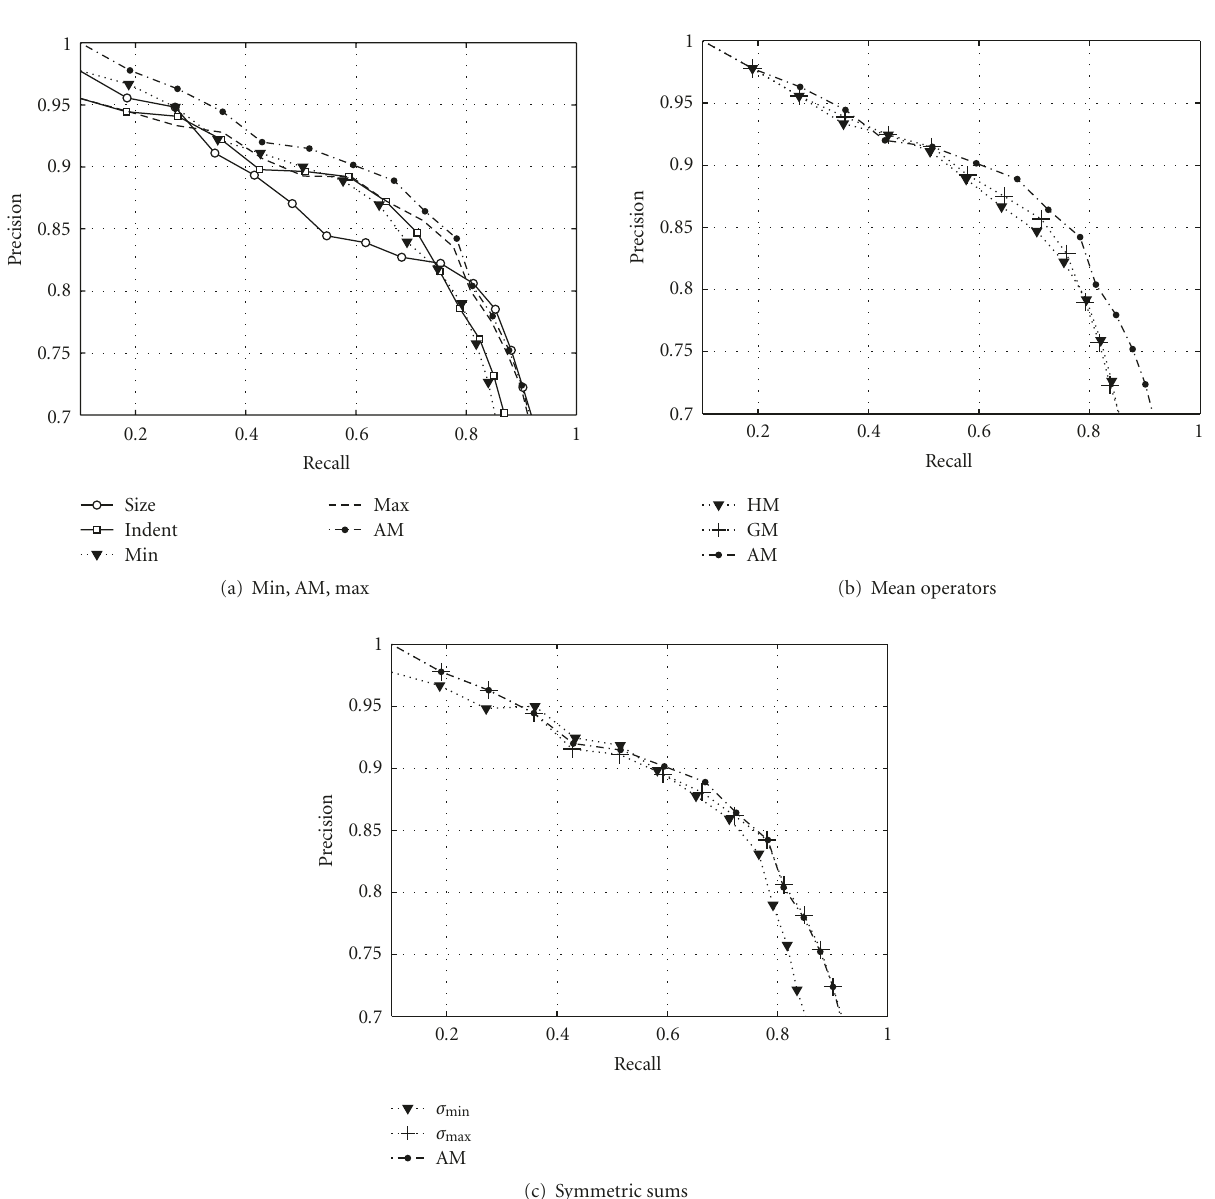
Figure 12: Precision-recall curves for aggregation of size and indent features using various aggregation